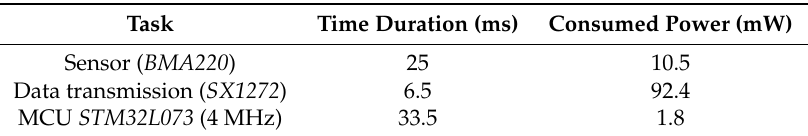
Table 6. Characteristics of sensor node tasks.